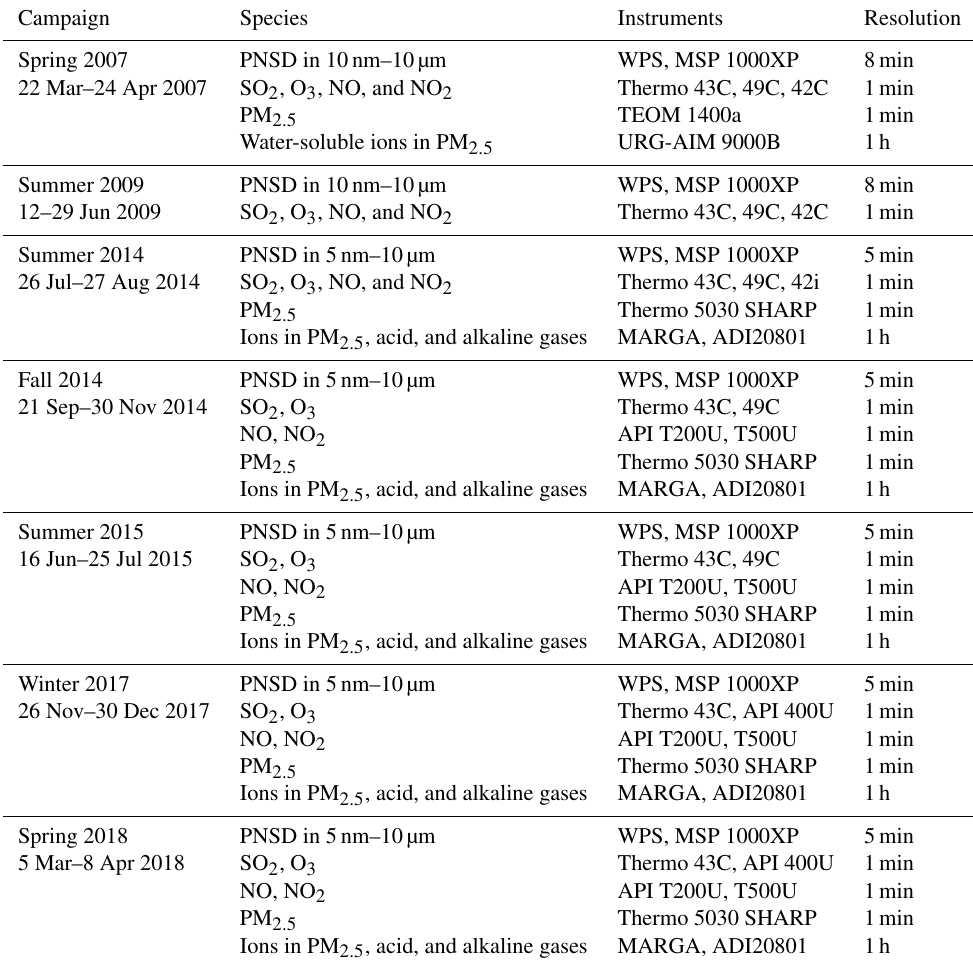
Table 1. Summary of the seven observation campaigns at Mt. Tai. Campaign